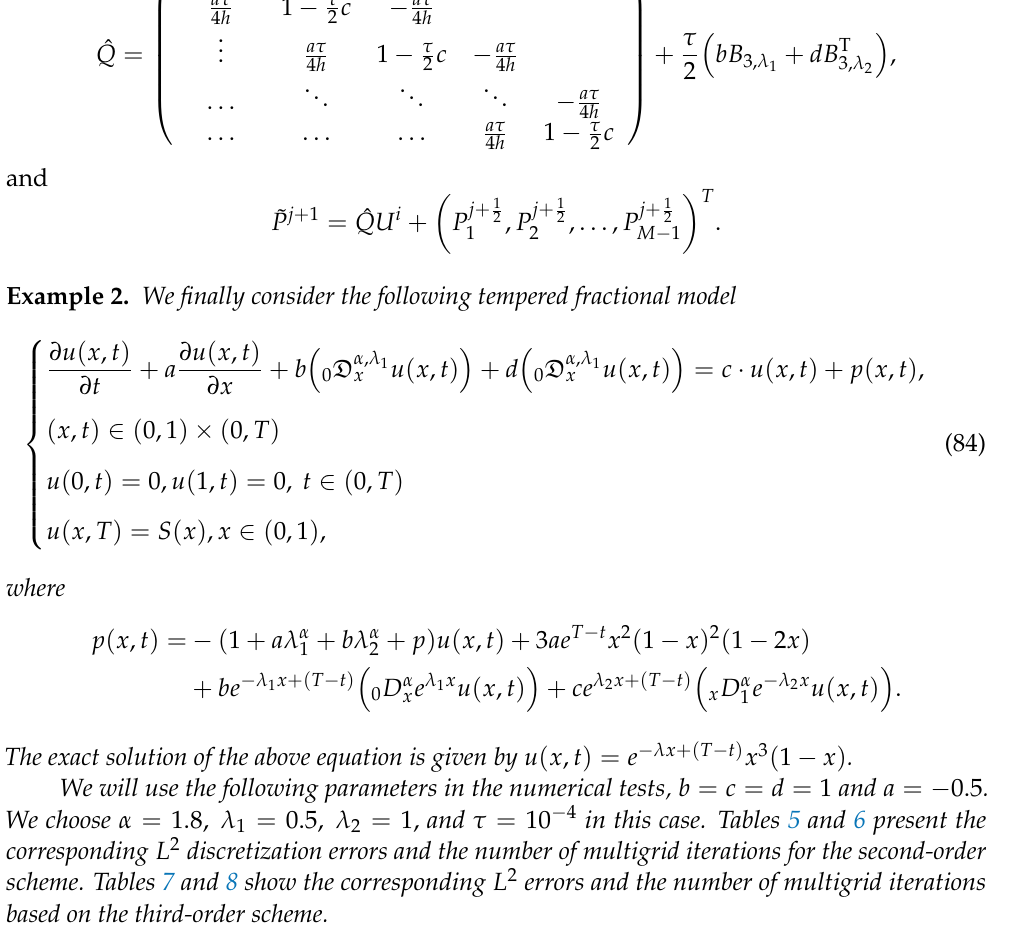
Table 5. L 2 errors for (84) with different ω by the second-order scheme.